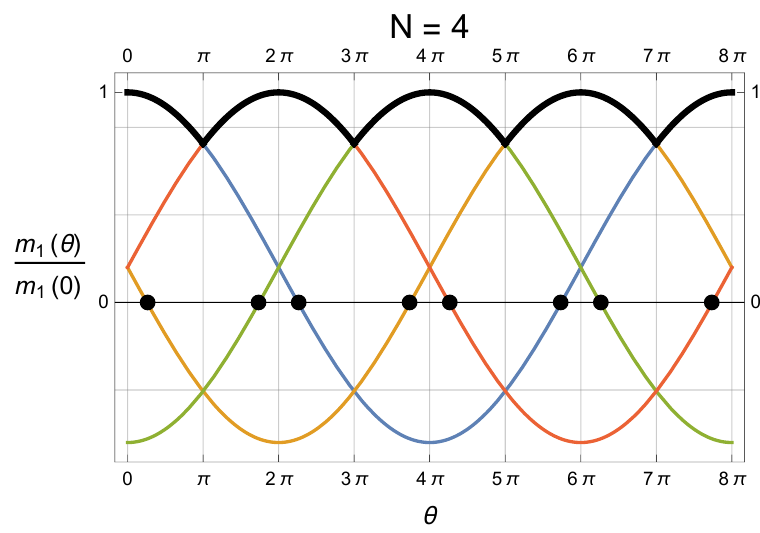
Figure 3 . [Color Online.] Plot of the mass of the lightest excitation of YM theory with N = 4 at small NL (cid:3) as a function of (cid:18) , normalized to its value at (cid:18) = 0, with magnetic bion e(cid:11)ects taken into account. The thick black curve at the top marks the behavior of the gap along the thermodynamically stable branch. Each of the four colored curves show the dependence of the mass on (cid:18) in a given k -extremum, with blue, red, green, orange corresponding to k = 0 ; 3 ; 2 ; 1 respectively. The black dots mark spinodal points, and the fact that there are two distinct spinodal points near (cid:18) = 2 (cid:25)k; k 2 Z is due to magnetic